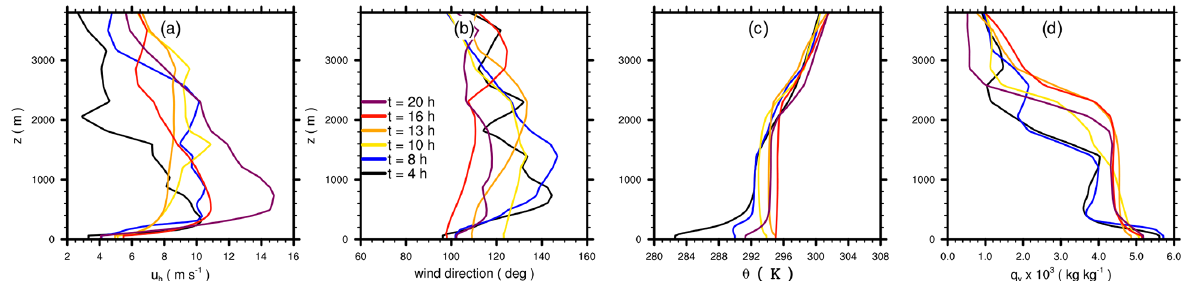
Figure 7. COSMO-derived vertical profiles of (a) horizontal wind speed, (b) mean-wind direction, (c) potential temperature, and (d) specific humidity prescribed at the lateral domain boundaries at different points in time after the start of the simulation at 00:00UTC.